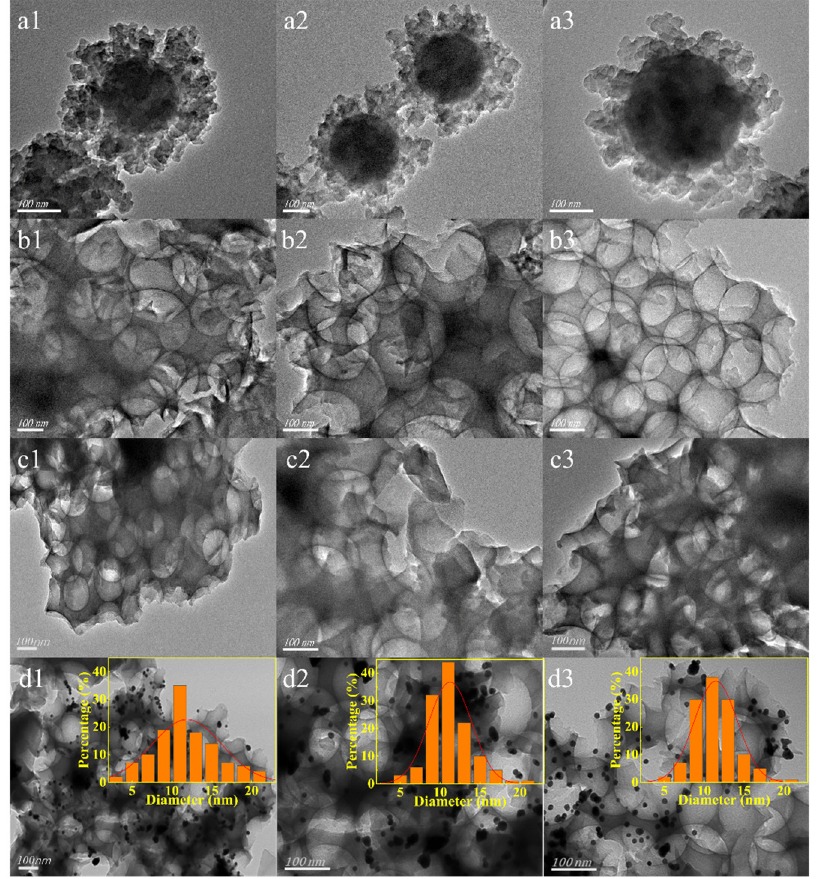
Figure 2. TEM images of SiO 2 @Poly x ( a1 – a3 ), BN x C ( b1 – b3 ), N-BN x C ( c1 – c3 ), and Au 1 Pd 1 /N-BN x C